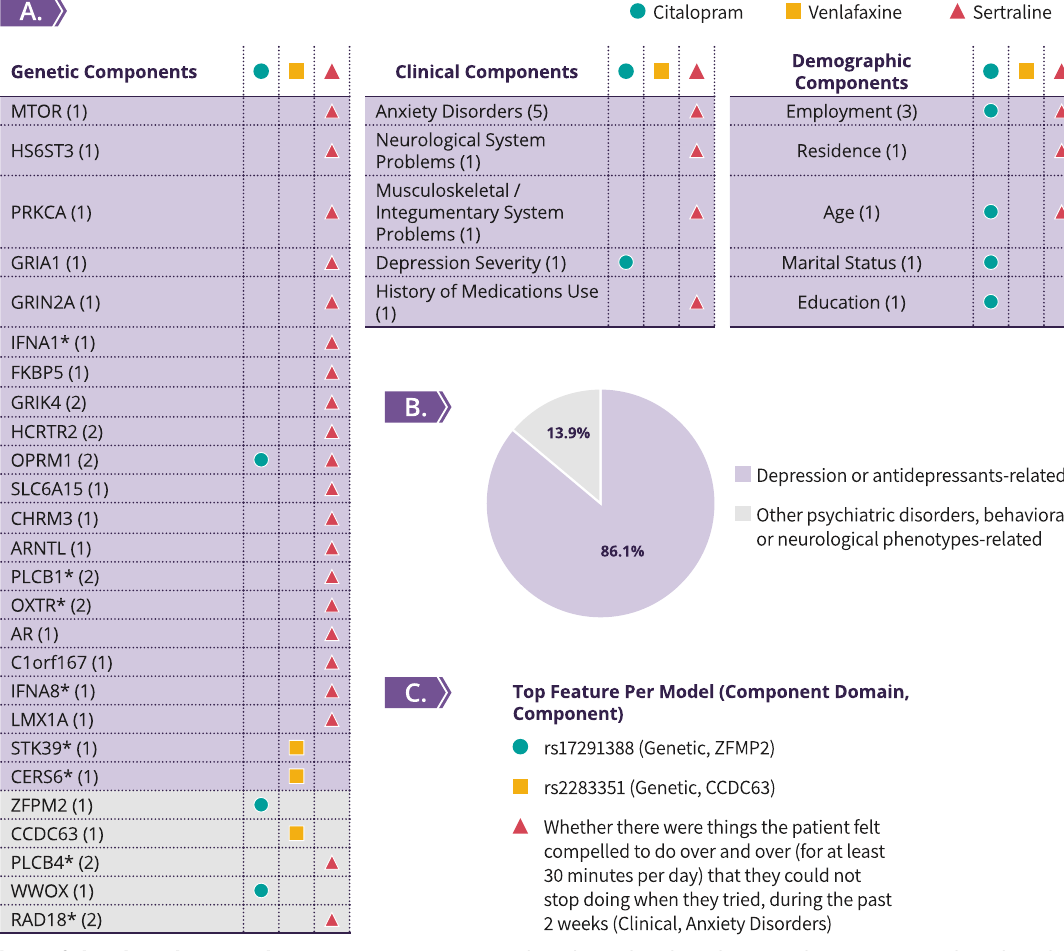
Fig. 2 Analysis of the algorithm ’ s predictive components. A List describing the algorithm ’ s predictive genetic, clinical, and demographic components (within parentheses are the number of features that are mapped to each component, while the asterisks represent components whose mapped genetic features do not reside within the mentioned functional gene itself, but rather in an adjacent intergenic region), with marking per medication. B Pie chart describing the distribution of the selected components according to the two classes, following the scienti fi c literature explorations. Only if associations of a component to depression and/or antidepressant were not found, we examined whether it was found to be associated with other psychiatric disorders or neurological phenotypes. C Top feature per medication ’ s fi nal model (according to ROC curve variable importance or absolute coef fi cient